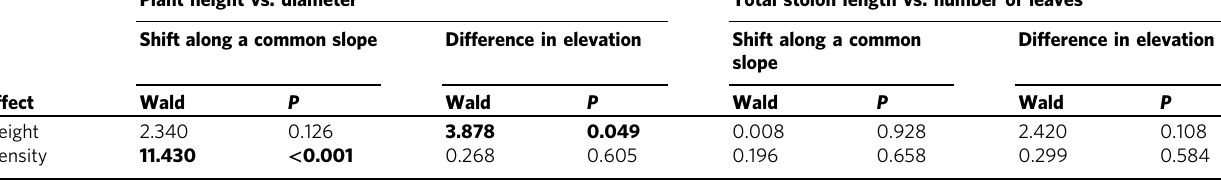
Table 2 Standardised major axis (SMA) results for the effect of treatments on the allometric relationships between plant traits Plant height vs. diameter